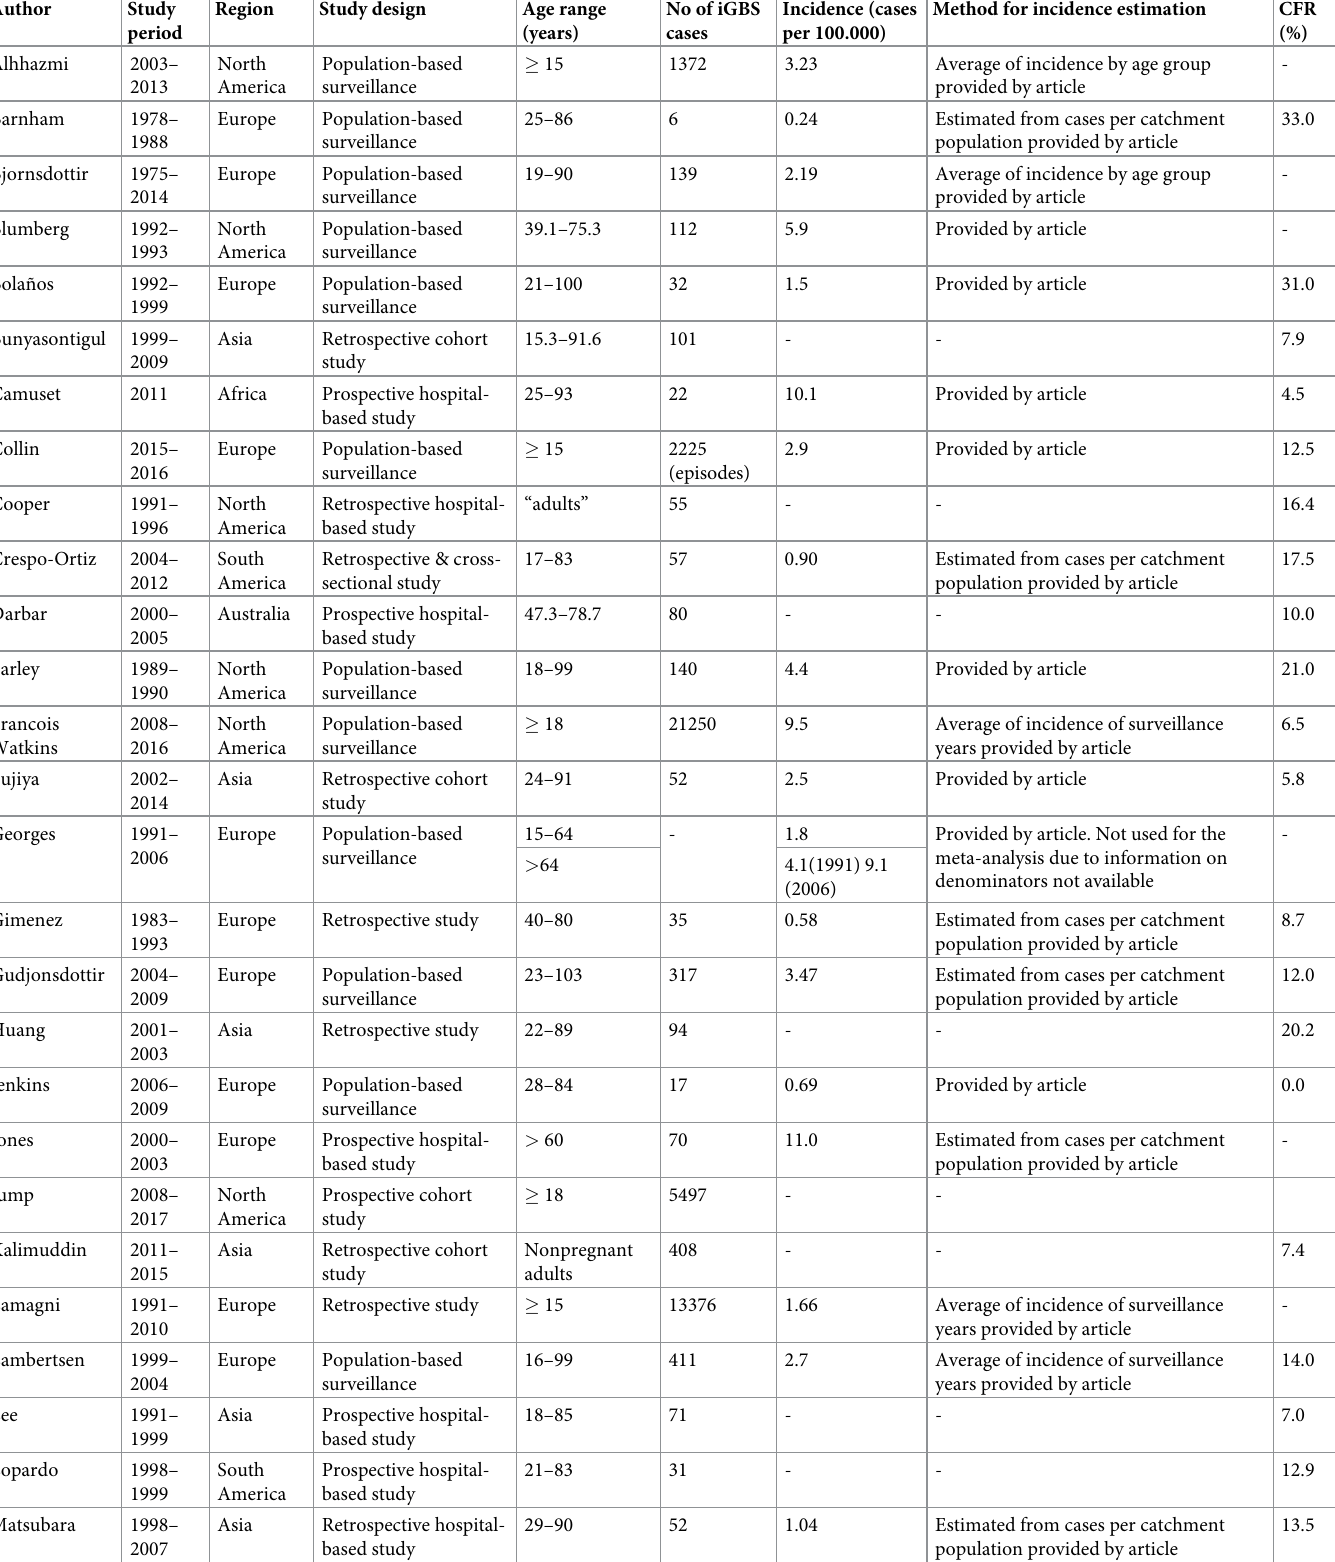
Table 1. Summary of included